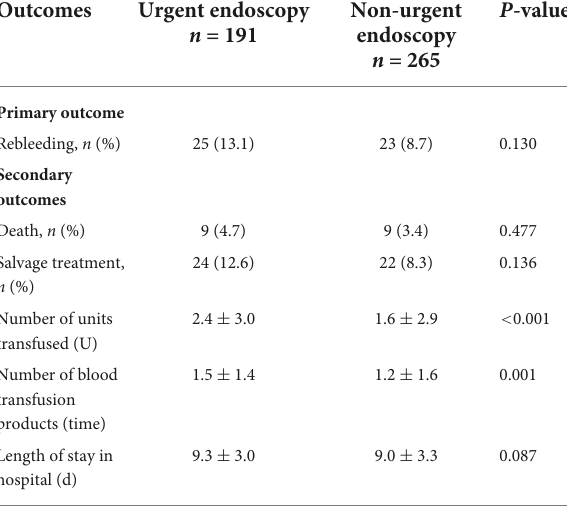
TABLE 3 Clinical outcome of patients in urgent ( ≤ 12 h) and non-urgent ( > 12 h) endoscopy before propensity score matching (PSM).